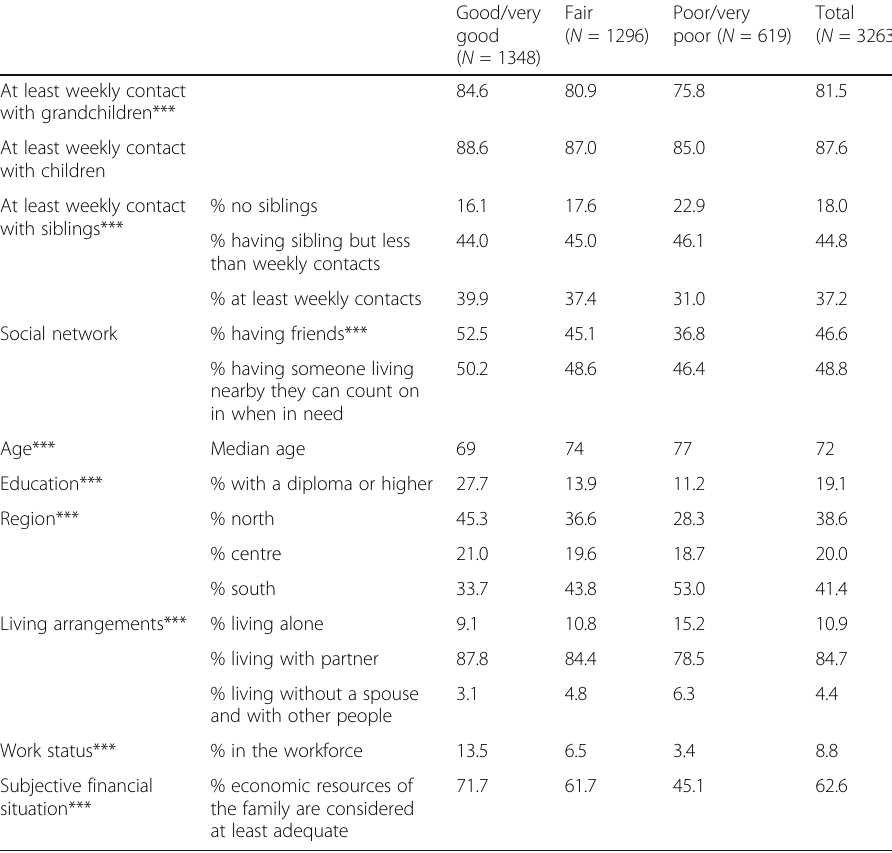
Good/very Fair Poor/very Total good ( N = 1296) poor ( N = 619) ( N = 3263) ( N = 1348)